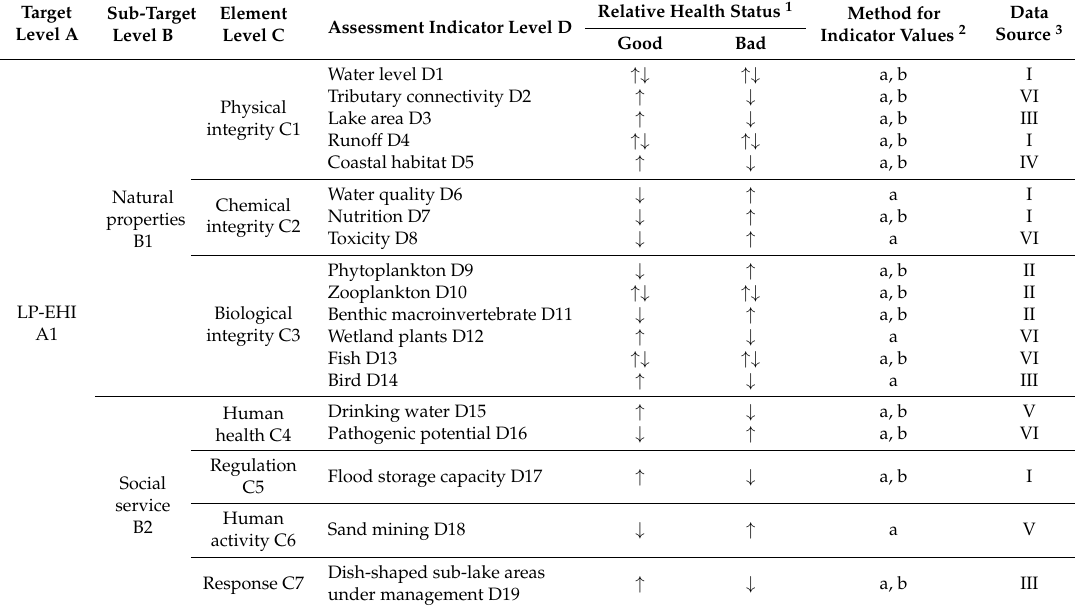
Table 2. Ecological indicators and their relative health status, methods and data source.